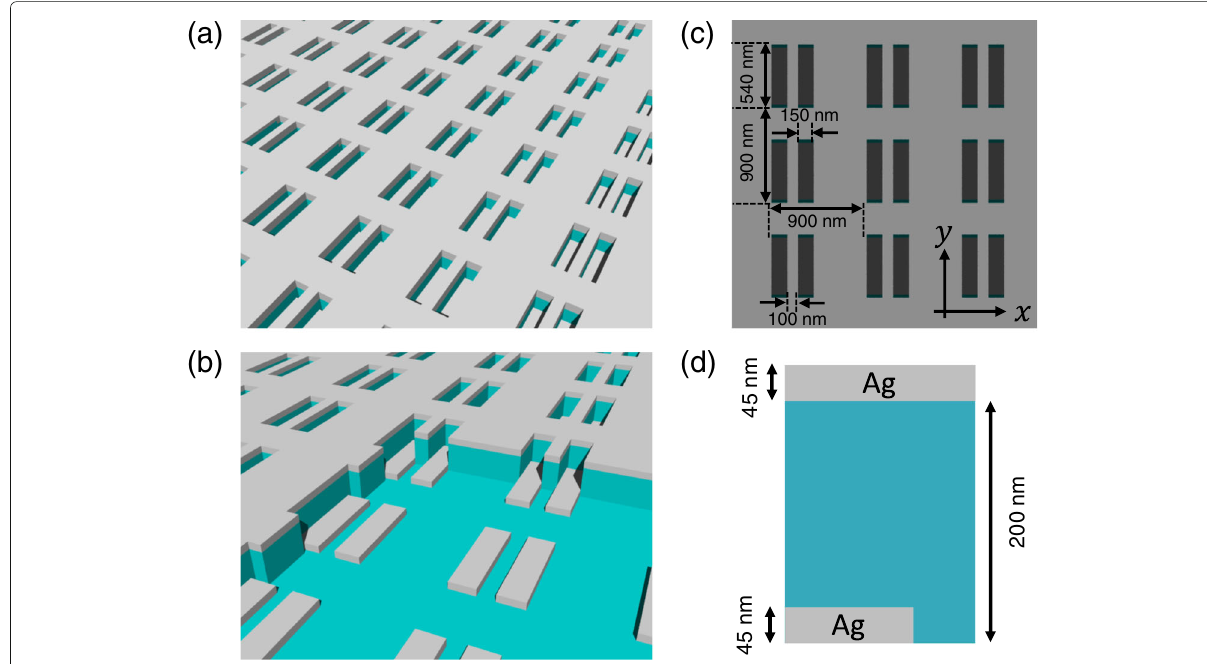
Fig. 2 A schematic of the metasurface polarizer ( a ) that comprises three layers ( b ). The metasurface has an array of rectangular hole pair with a period of 900 nm in the x and y directions ( c ). The thicknesses of the metallic and dielectric layers are 45 and 200 nm, respectively ( d